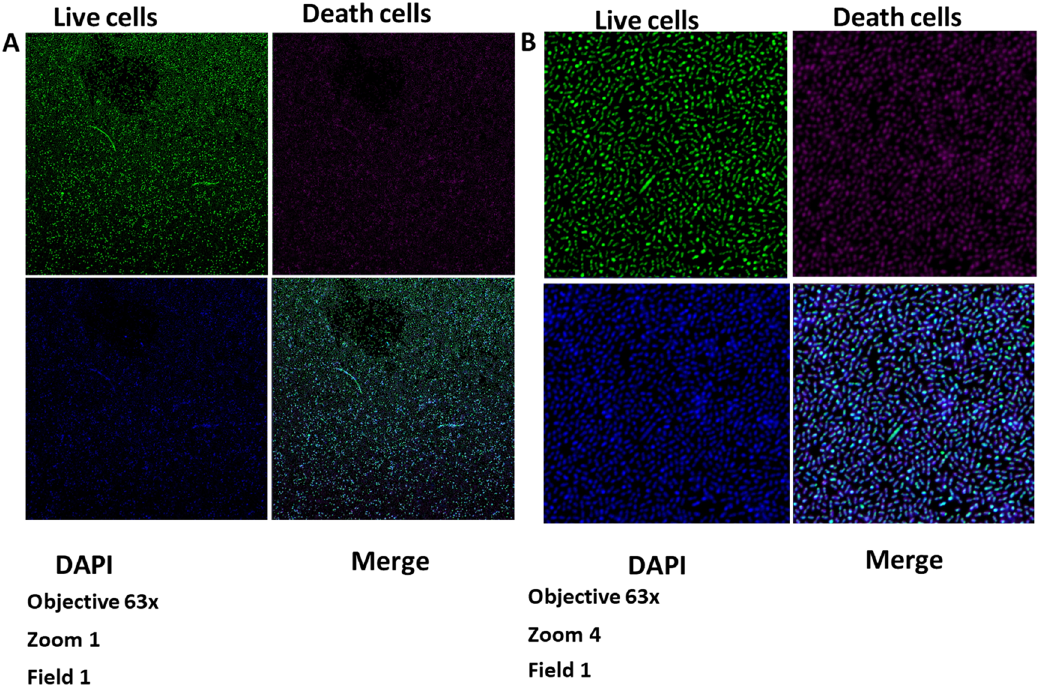
Figure 1. Growth of the biofilm of S. gordonii (ATCC ® 51656 ™ ) and F. nucleatum (ATCC ® 10953 ™ ) at 48 hours. Images taken by confocal microscopy (Zeiss LSM 880). A) Zoom 1. B) Zoom 4. DAPI, 4 0